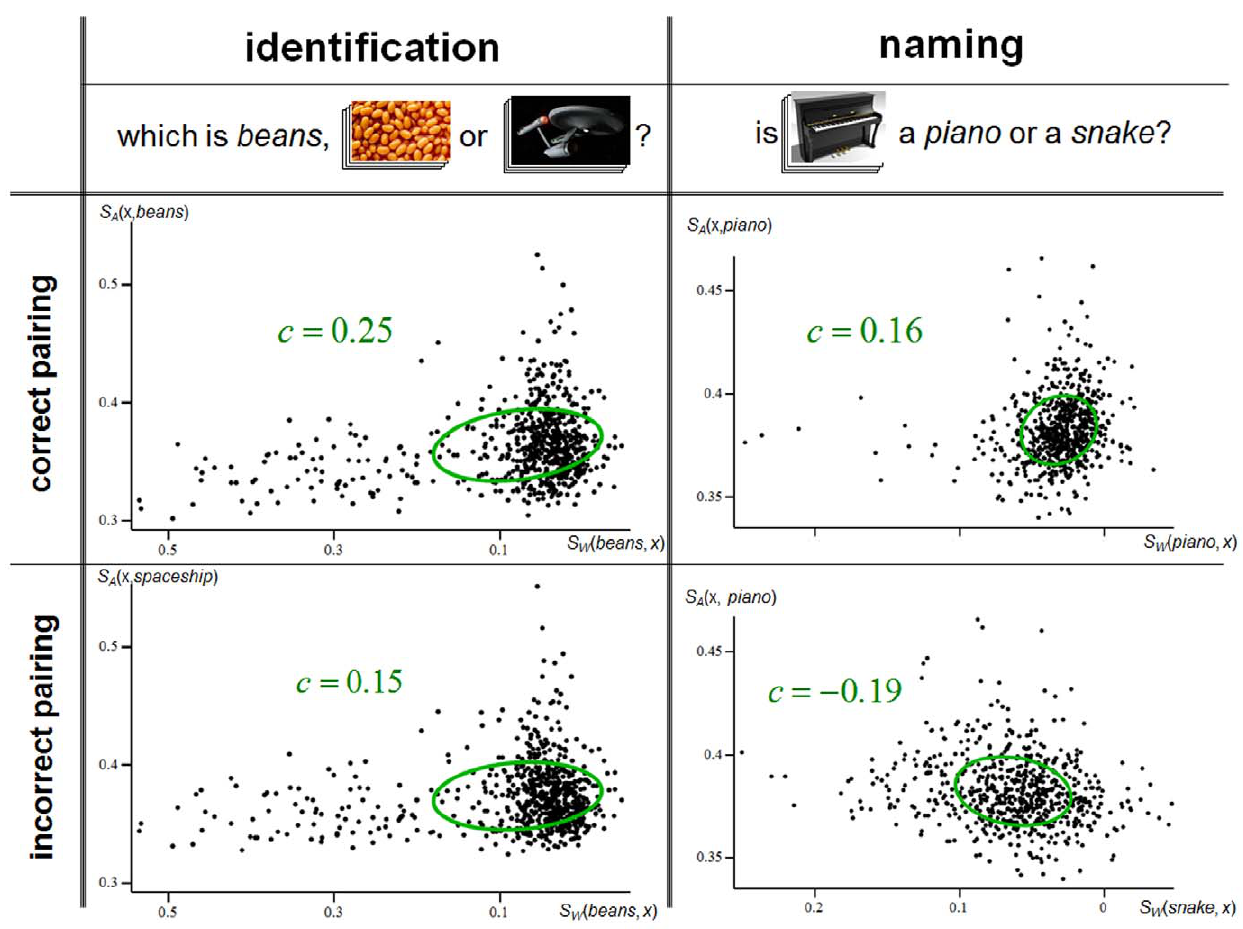
Figure 5. Example trials of identification and naming. The left column illustrates an example identification task, the right an example naming task. In both tasks the aim is to choose a correct pairing of a word and an appearance over an incorrect one. The plots in the upper row show data for the correct pairings, those in the lower for the incorrect. Each scatter plot relates to a different pairing of word ( W ) and appearance ( A ). For example, the top-left plot relates to S W , A T ~ S beans , beans T , the pairing of the word beans with the appearance of beans ; while the bottom-right plot relates to S W , A T ~ S snake , piano T , the word snake with the appearance of piano . x is a variable ranging over the words of known appearance. Each scatterplot has a point for each possible value of x . The horizontal coordinate of the points indicates S W W , x ð Þ , the word similarity; and the vertical coordinate indicates S A x , A ð Þ the appearance similarity. For both axes, values nearer the origin indicate greater similarity. The correlation of the points in a plot is visually indicated by the green covariance ellipses, and nearby them we give the correlation value. In both examples, the more positive correlation is in the upper row, so the correct pairing is identified.